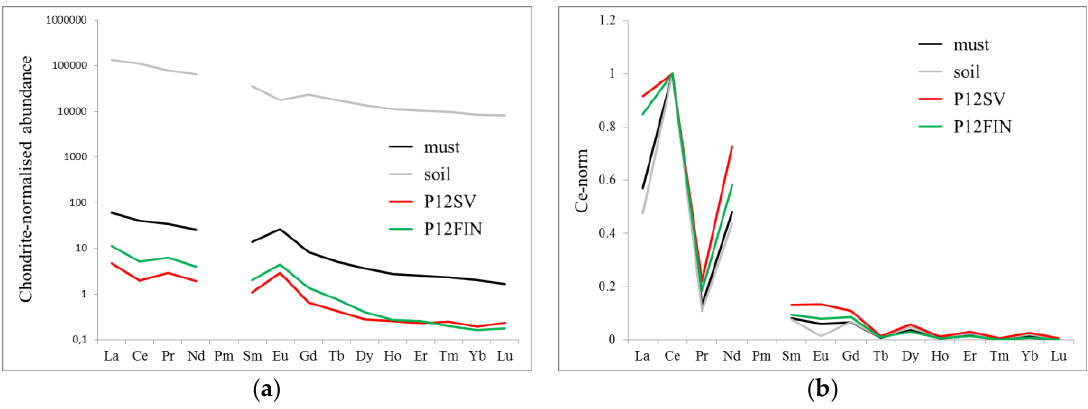
Figure 4. REE distributions in must, soil, and wines after fermentation processes: ( a ) chondrite-normalized values; ( b ) Ce-normalized values.